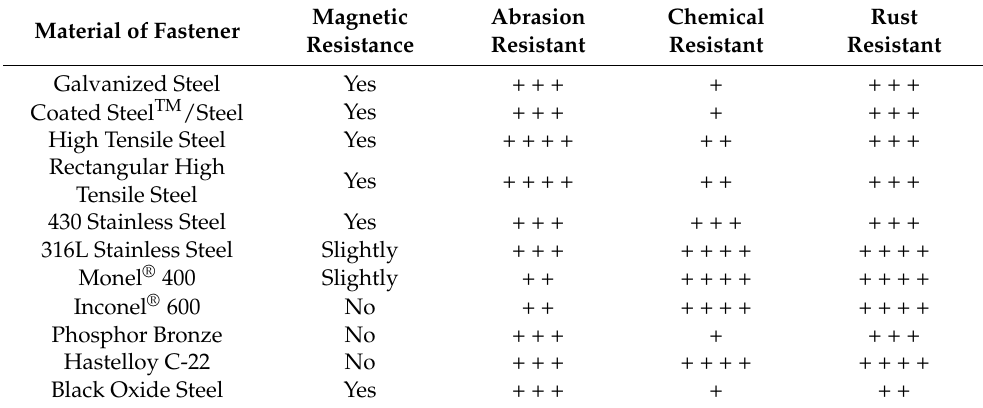
Table 8. Fastener Material Characteristics ranging from one plus sign (+) to four plus signs (+ + + +) [25]. Magnetic Abrasion Chemical Rust Material of Fastener Resistance Resistant Resistant Resistant Galvanized Steel Yes + + + + + + + Coated Steel TM /Steel Yes + + + + + + + High Tensile Steel Yes + + + + + + + + + Rectangular High Tensile Steel 430 Stainless Steel Monel ® 400 Slightly Inconel ® 600 Phosphor Bronze Hastelloy C-22 Black Oxide Steel